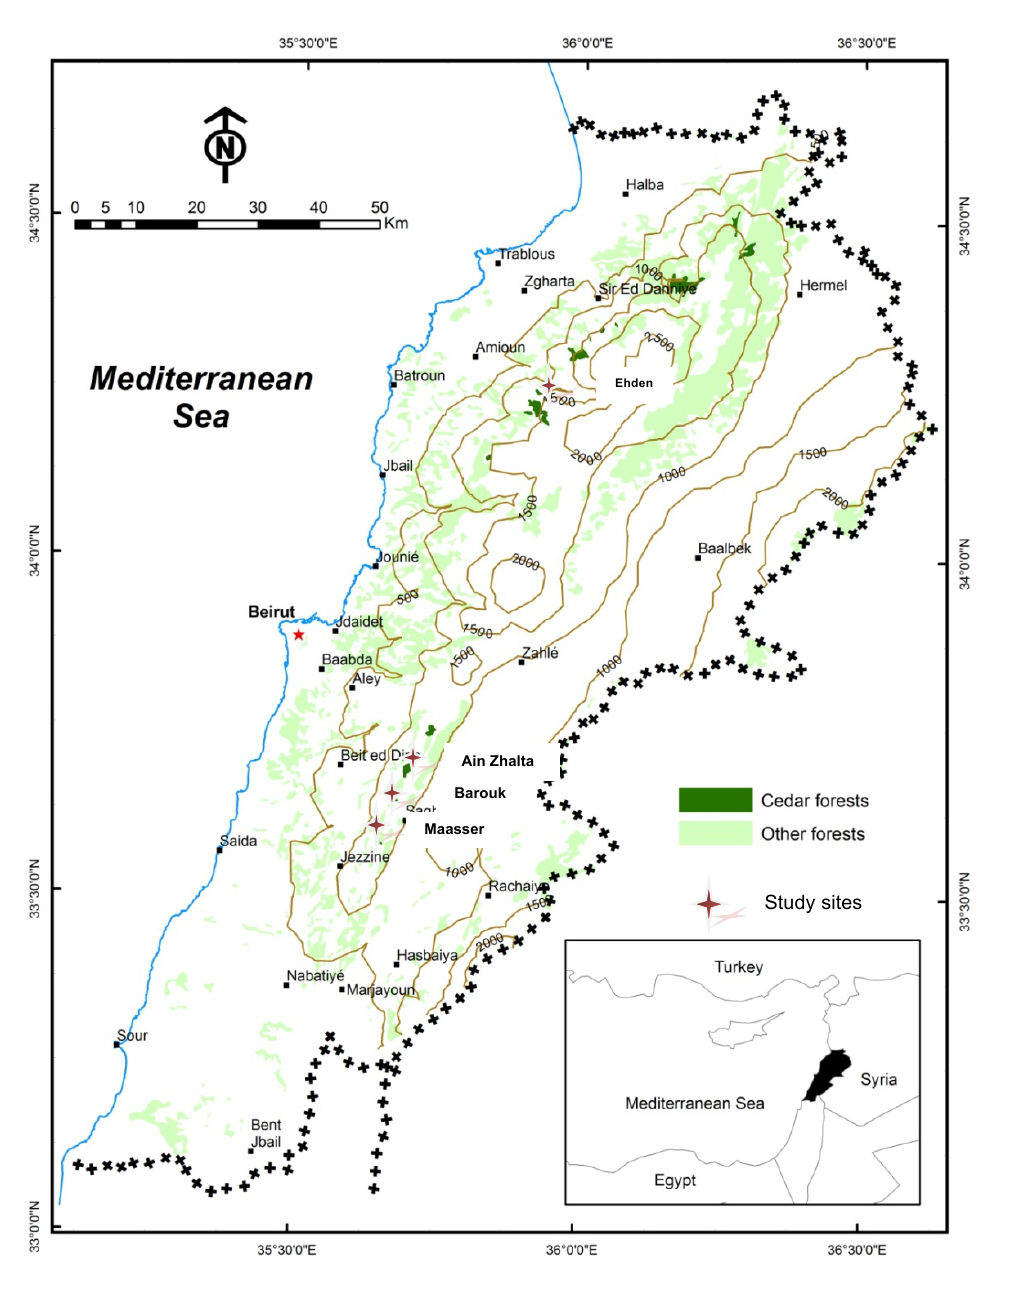
Figure 1. Study sites location and distribution of 12 populations of cedar in